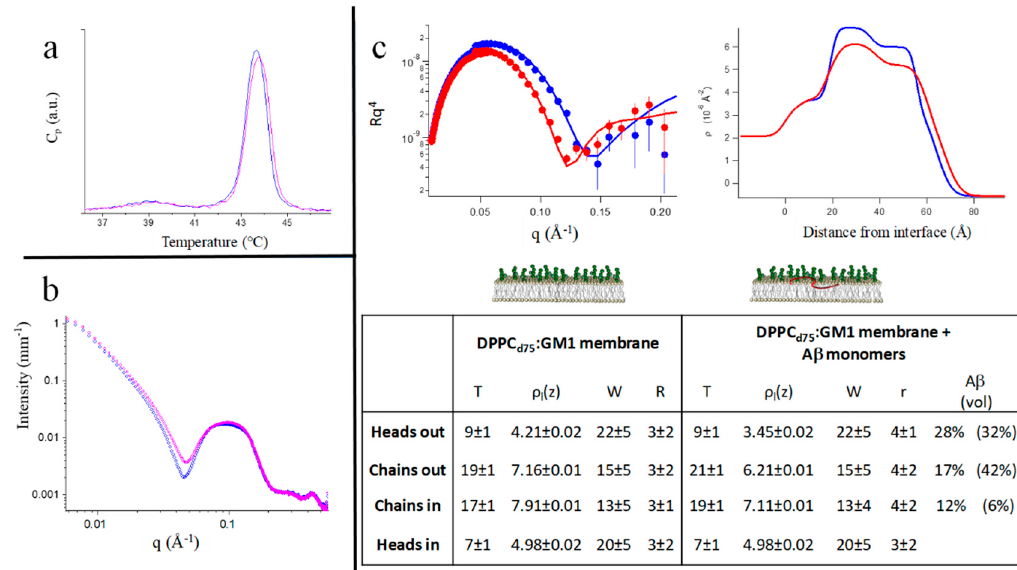
Figure 3. Mixed PC-phospholipid: GM1-ganglioside bilayers upon interaction with A β monomers. ( a ) DSC results. Heating scan of DPPC:GM1 vesicles before (blue line, pretransition at T p = 39 °C, T m = 43.65 °C) and after contact with A β mon(1–42) (magenta line, T m = 43.75 °C). T-scan rate: 0.25 °C/min. ( b ) SAXS results. SAXS spectra of DPPC:GM1 vesicles before (blue diamonds) and after 1 h incubation with A β mon(1–42) at T = 50 °C (magenta open dots). Both spectra were taken at T = 26 °C, gel-phase. ( c ) neutron reflectometry (NR) results. NR spectra (left panel) of the single deposited DPPC d75 :GM1 membrane, before (blue symbols) and after (red symbols) interaction with A β mon(1–40), together with the corresponding contrast fits. In the right panel, the obtained scattering length density profiles. T =